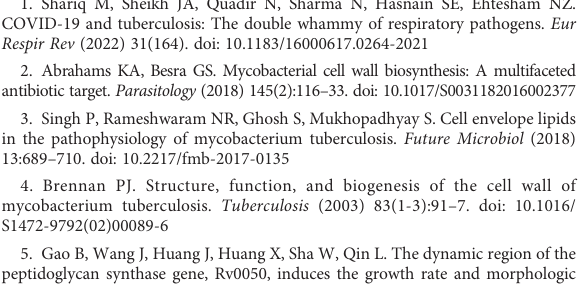
SUPPLEMENTARY FIGURE S4 (A) Uptake of knock-down strains by human THP-1 cells and shGalectin9 (Galcetin9 knock-out onthe basis ofTHP-1) cells whencellsinfected with MOI=5 48h post infection. (B, C) Intracellular CFU counts of EmbA_KD strain when shGalectin9 cells infected with MOI=5 48h post infection. Data are plotted as mean ± SD. Two-way ANOVA tests are used for all signi fi cance analysis here; **: P <0.01; **: P <0.01; ***: P <0.001; ****: P